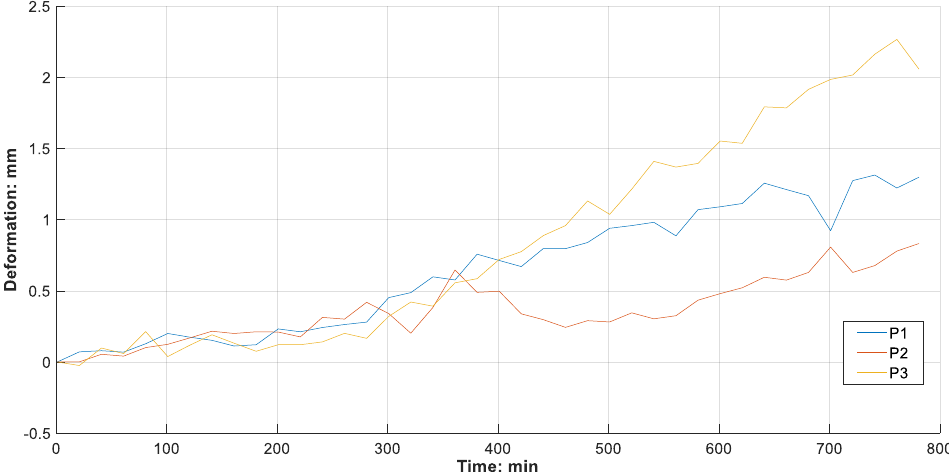
Figure 22. Real deformation curves of three research points. P1 is located at the crown cracks, P2 is located at the head, and P3 is located at the minor scarp. According to the analysis curve, the deformation rate of the three points is different, but all of them keep rising.